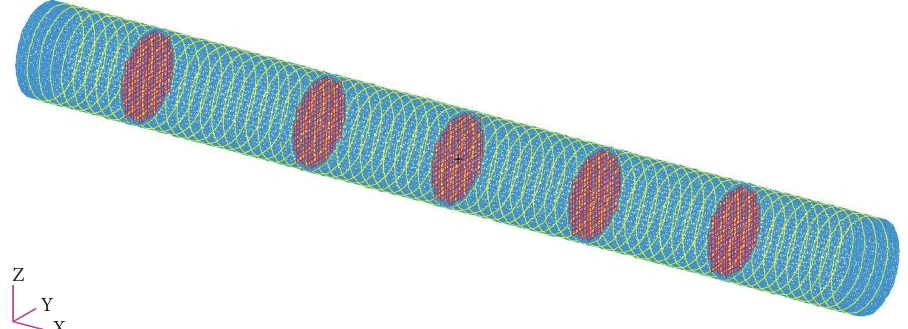
Figure 10: Finite elements of the structure.